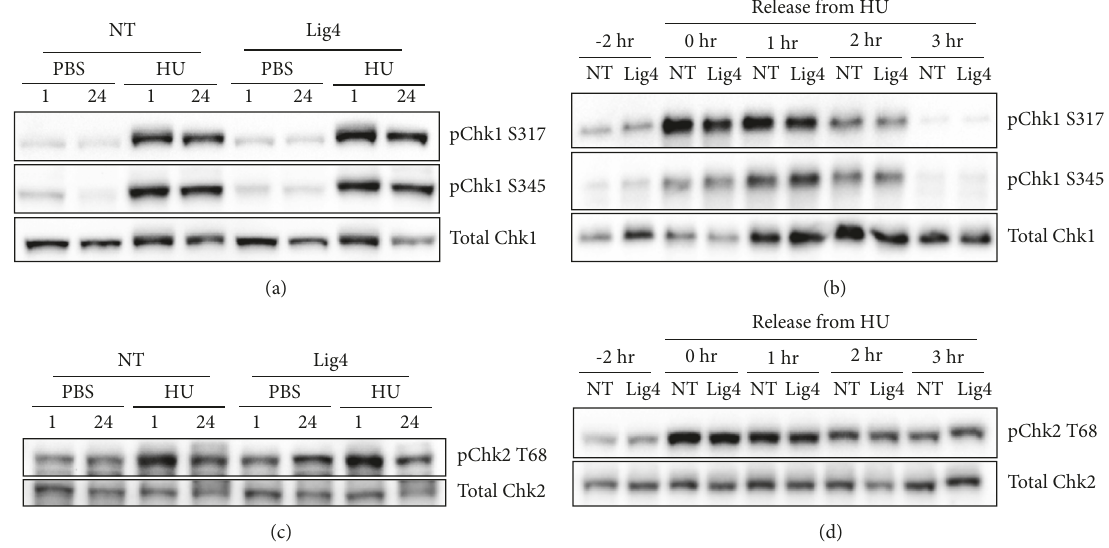
Figure 5: Lig 4 d epletion d oes not increase Ch k1 or Ch k2 phosphor y lation or d ephosphor y lation. pChk1 (Ser317 or Ser345), pChk2 (Thr68), total Chk1, or total Chk2 were assessed via western blot. The experiment was repeated three times. (a, c) Lig4 depleted or scrambled control treated (NT) cells were treated with 10 mM hydroxyurea or PBS for 1 or 24 hr. (b, d) Lig4 depleted or NT cells were treated with 10 mM HU or PBS for 1 hr and released for indicated